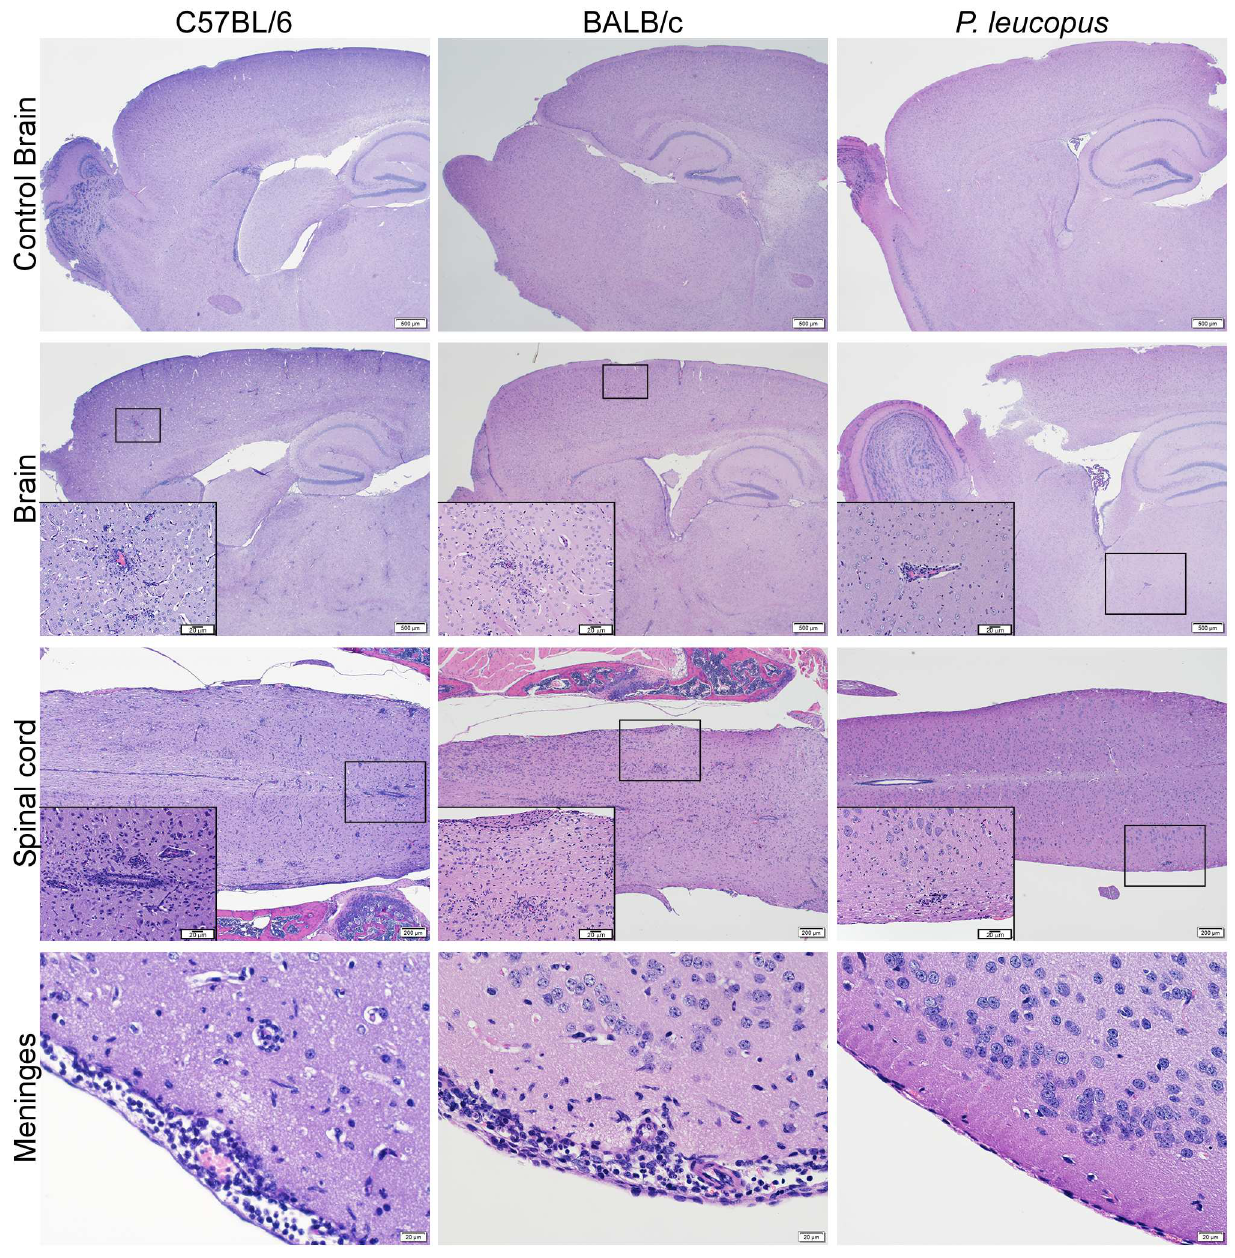
Fig 4. Hematoxylin and eosin-stained sections of brain and spinal cords obtained from i.c.-inoculated mice. The terminalbrain sections of C57BL/6 (5 dpi) and BALB/c (4 dpi) mice show moderate lymphocytic perivascular cuffing and microgliosis, but these lesionswere mild in P . leucopus brains(image obtainedfrom mouse sacrificedat 15 dpi). Peromyscusleucopus spinalcords showedminimallymphocytic perivascular cuffing and microgliosis, but BALB/c and C57BL/6spinal cords showed moderate lesions. Normal meninges were observedfor Peromyscus leucopus ,but the meninges of BALB/c and C57BL/6mice had moderate lymphocytic infiltrates. viral RNA were detectable at 1 dpi only in the subventricular white matter. From 2 dpi through to 7 dpi, POWV RNA was more abundant, but localized mainly to the olfactory bulb and ven- tricle (Fig 5A). Lesser amounts could be detected in the cerebral cortex, granular layer of the cerebellum and spinal cord (Fig 5A). However, the viral RNA was undetectable in P . leucopus